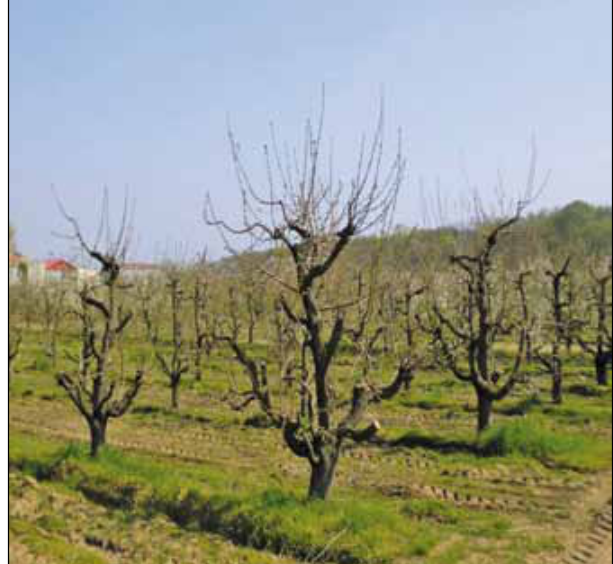
Photo 4 : One year after the pruning there are lots of shoot in the canopy